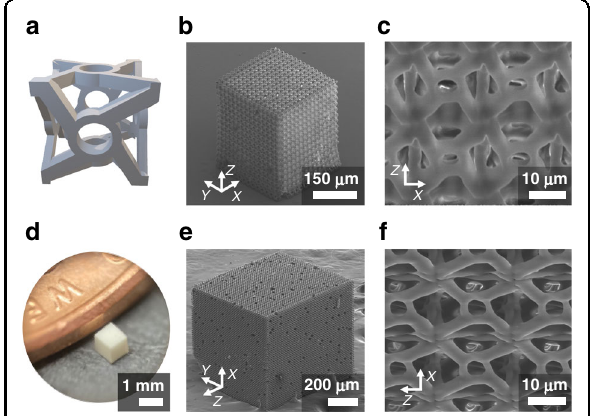
Fig. 6 Rapid 3D printing of macroscale metamaterial-like structures. a 3D CAD pro fi le of material unit cell. b 15 × 15 × 15 unit metamaterial-like structure fabricated with 400 µm s − 1 vertical stage speed for each unit. c Magni fi ed view of side of structure in b with view angle about 57° from substrate normal. d Optical image of 42 × 42 × 42 unit metamaterial-like structure situated near the edge of a United States one-cent coin. Each unit cell was fabricated with 1 mm s − 1 vertical stage speed. Including all stage motions at the same 1 mm s − 1 speed, total print time was about 2.3 hours. e SEM image of